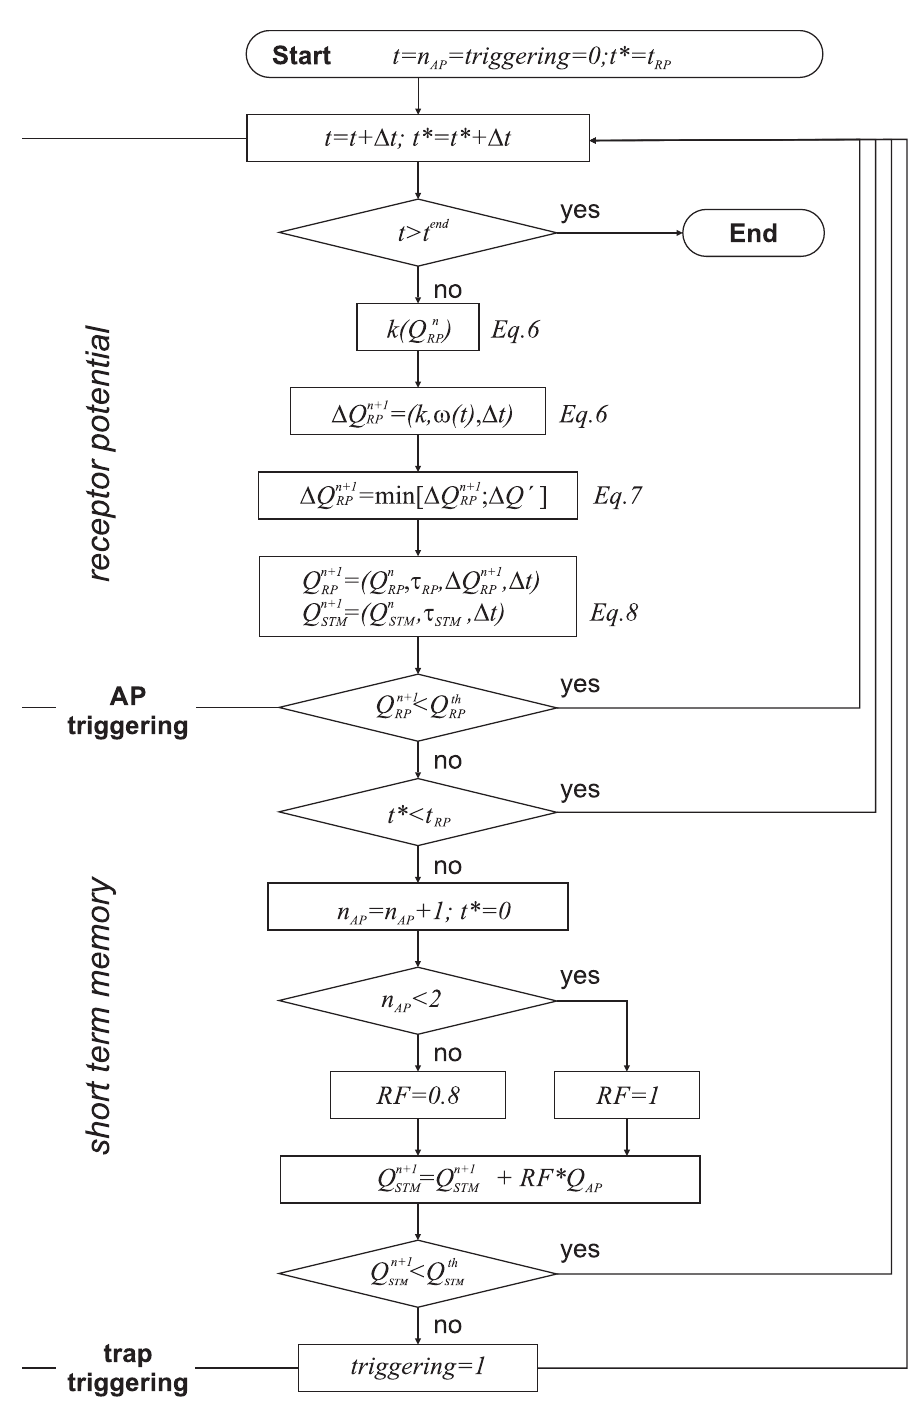
Fig 8. Flow diagram of the model implementation. t denotes the total time of the experiment, that goes from t = 0 up to t = t end , and t � is the relative time since the triggering of the last AP. Note that the reduction factor RF is kept as RF = 1 for the simulations. AP, action